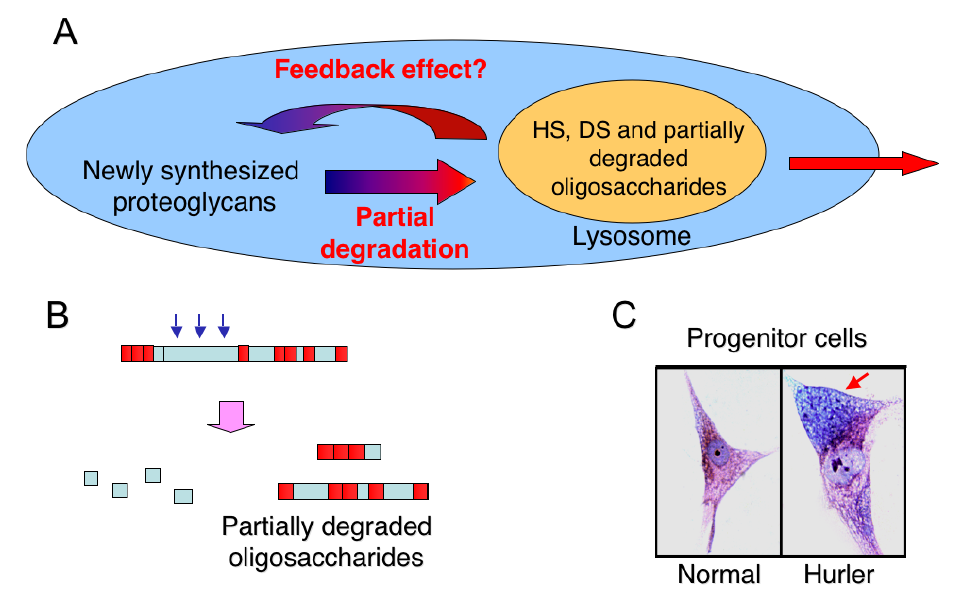
FIGURE 1. Lysosomal accumulation of partially degraded GAGs in Hurler syndrome. (A) Incompletely degraded HS and DS oligosaccharides accumulate in lysosomes. Some of these molecules are released outside the cell. The accumulated GAGs may possibly have feedback effects on the GAG biosynthetic pathways and on the expression of unrelated genes. (B) In the absence of IDUA, digestion of HS and DS chains into disaccharides is incomplete, since sequential digestion of the chains stops on reaching an iduronic acid residue (shown as red blocks). The remaining exoglycosidases and endoglycosidases are shown as blue arrows. (C) MAPC isolated from the bone marrow of patients with Hurler syndrome show lysosomal accumulation of GAGs, visible as a foamy blue region (red arrow).